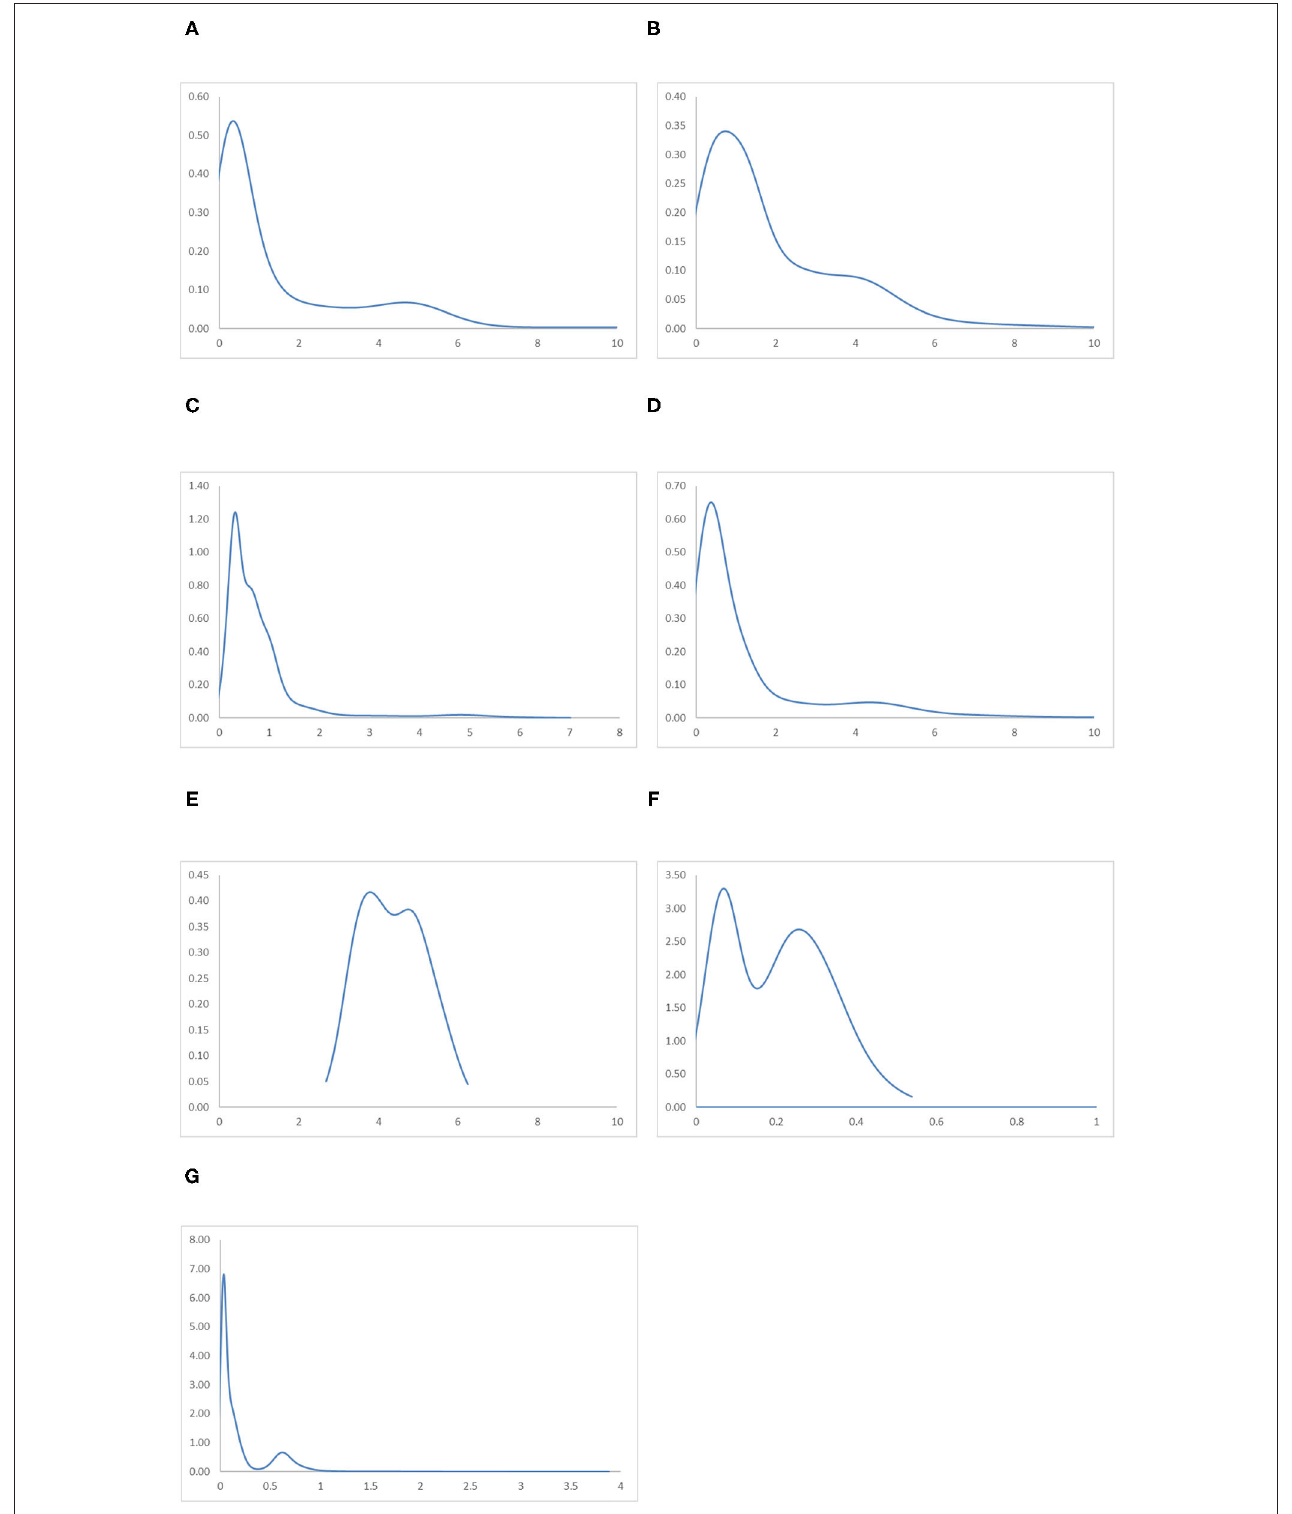
FIGURE 11 | Ergodic distributions for the RIVAPC of countries for different geographical regions with annual transitions. Source: authors’ calculation. N.B. The vertical axis indicates the density of probability and the horizontal axis indicates RIVAPC values. (A) East Asia and Pacific. (B) Europe and Central Asia. (C) Latin America and Caribbean. (D) The Middle East and North Africa. (E) North America. (F) South Asia. (G) Sub-Saharan Africa.